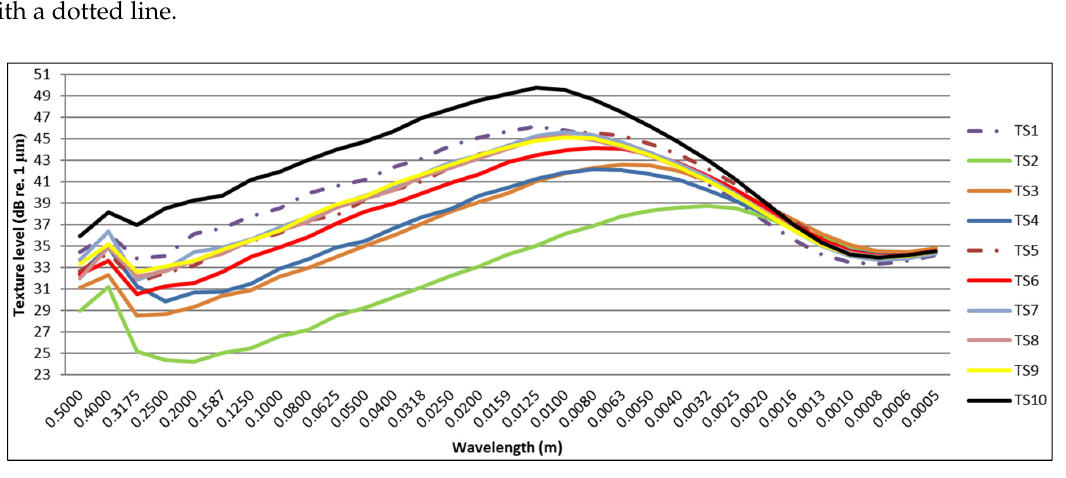
Figure 14. Overview of all texture spectra two months after construction.